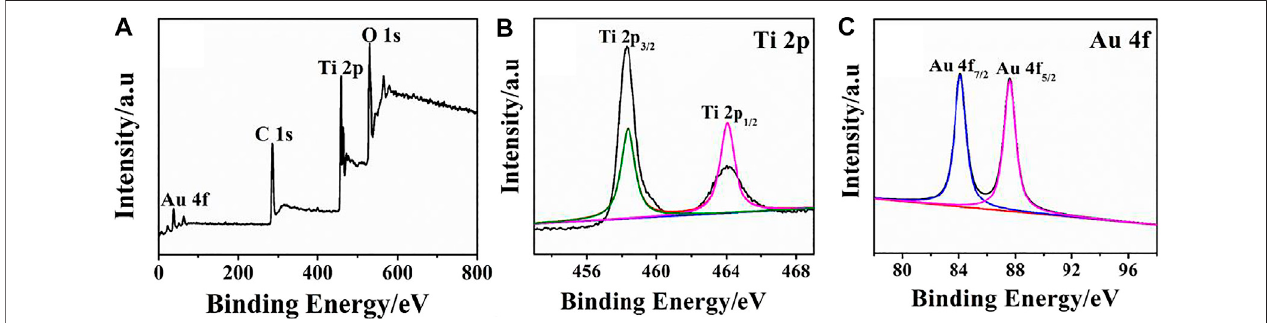
FIGURE 3 | XPS survey spectra (A) and high-resolution spectra of Ti 2p (B) and Au 4f (C) of the rGO – TiO 2 – Au nanocomposites.